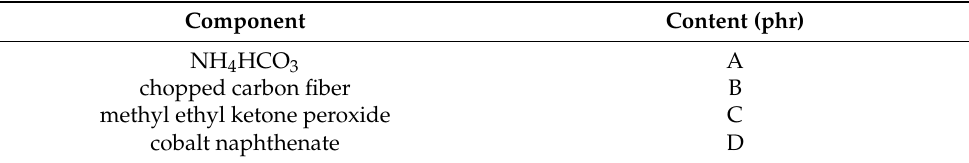
Table 1. Component of CCFR-LDUPR composite samples.